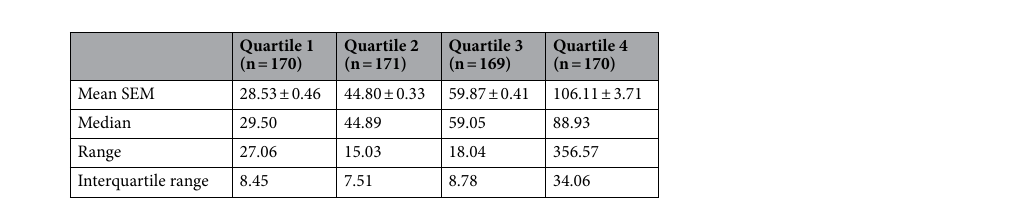
Table 2. Distribution of telomere length in